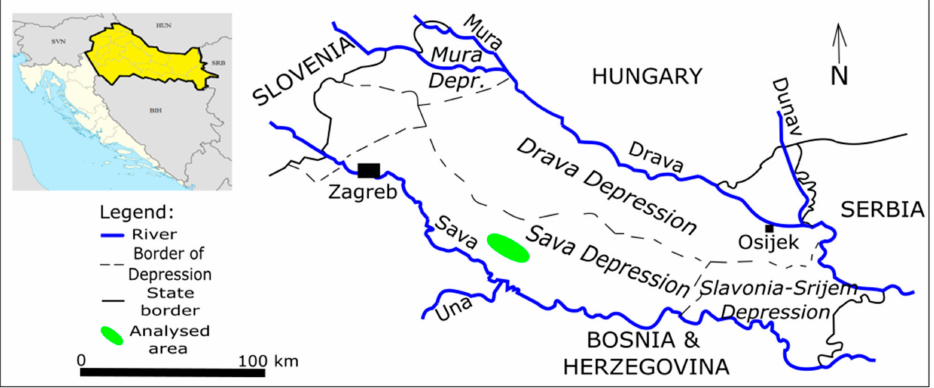
Figure 1. Geographic position of “A” and “B” Fields within the Sava depression (in Northern